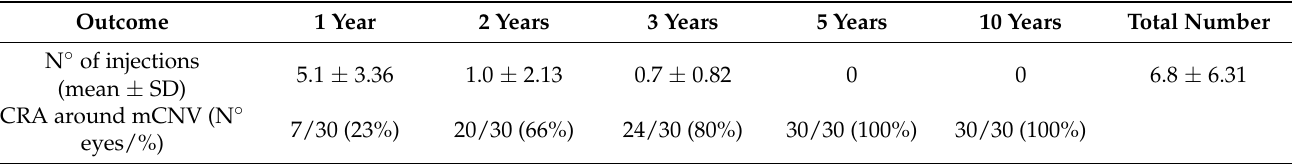
Table 2. Change in number of IVB injections and incidence of CRA during the 10-year follow-up period.